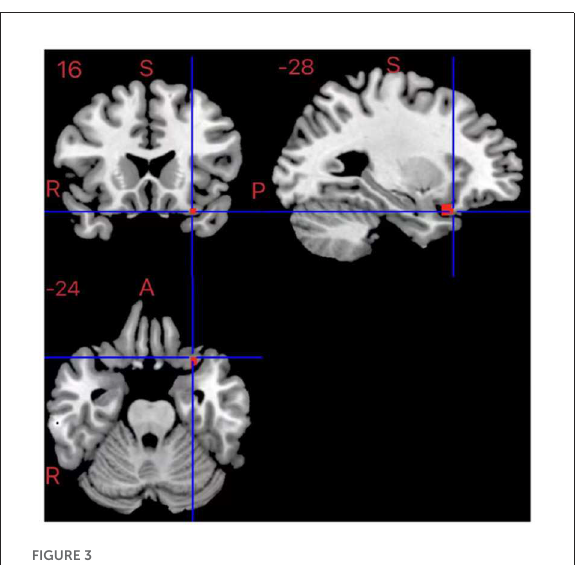
FIGURE3 Results of multimodal VBM and fMRI for